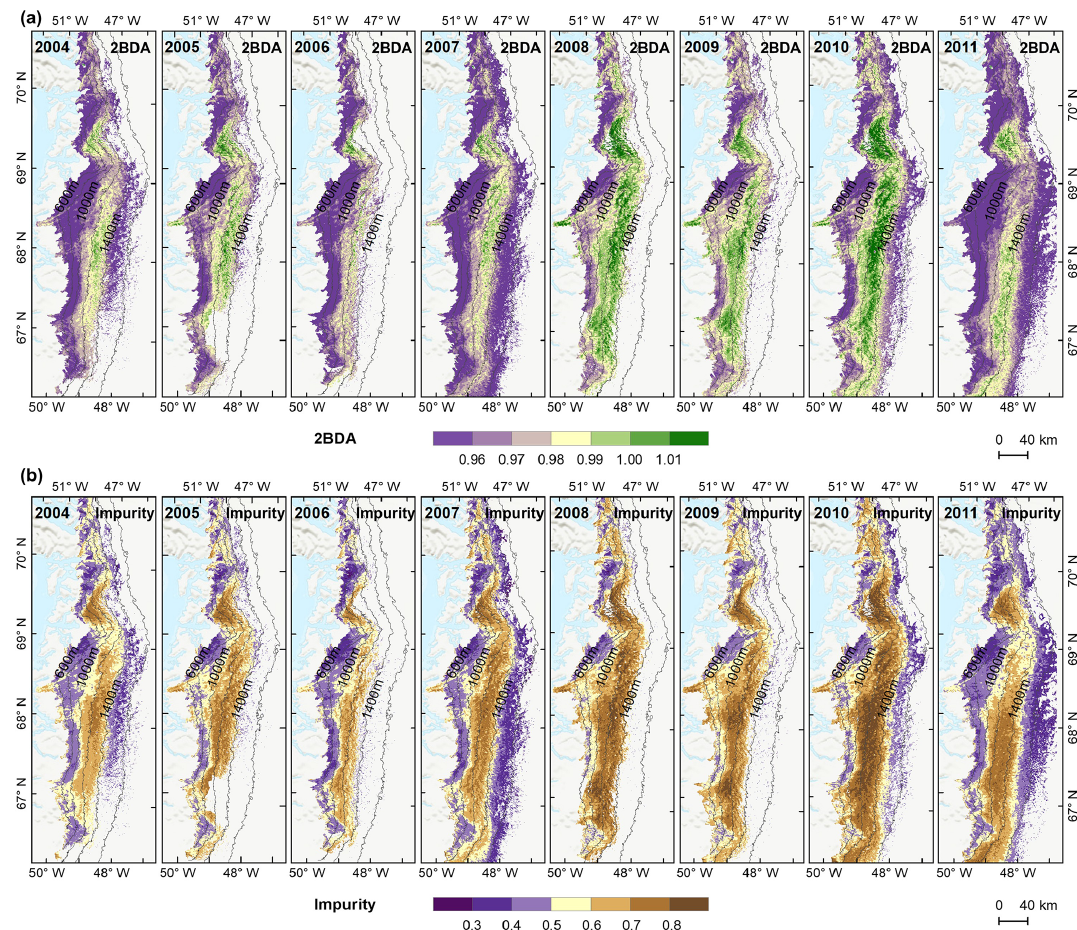
Figure 6. Maps of mean 2BDA index (a) and impurity index (b) over July and August from 2004 to 2011.